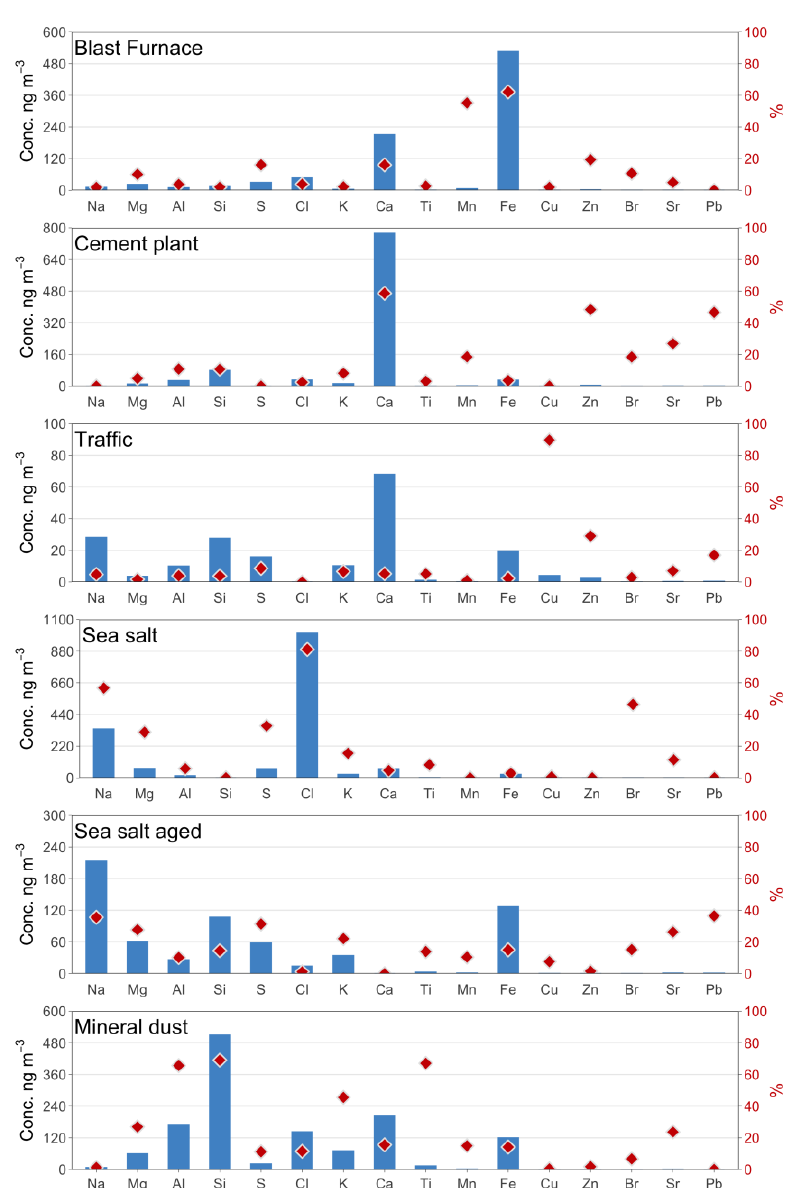
Figure 7. Source profiles obtained by PMF analysis of the coarse fraction dataset: contribution of each species to the chemical profile composition of each source (ng / m 3 , blue bars) and average percentage contribution of each source to the concentration of each element (%, red diamonds).